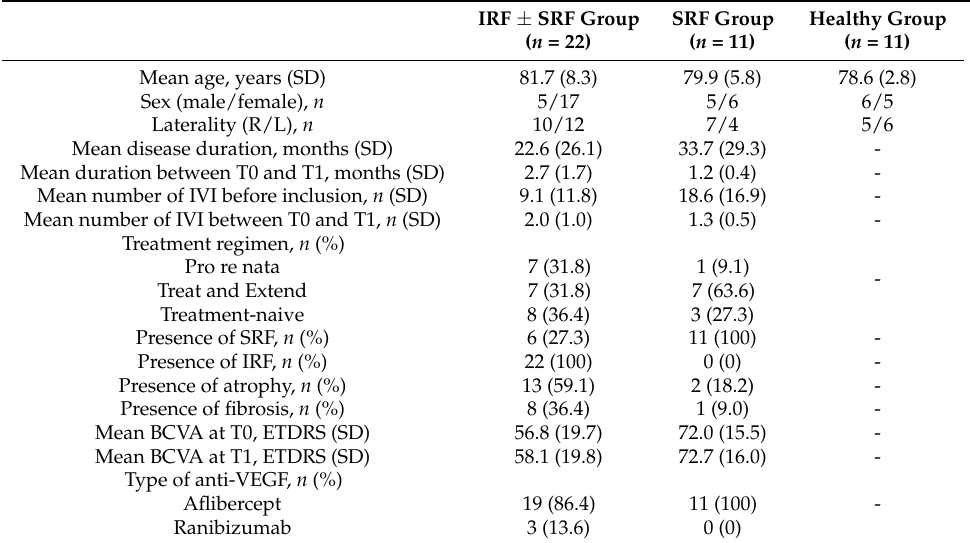
Table 1. Patient characteristics.